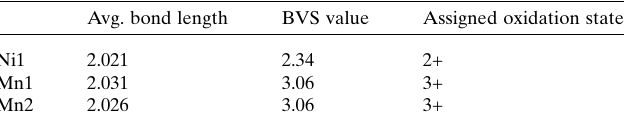
Table 1 Average bond length (A˚ ) and bond-valence-sum (BVS) values (v.u.) used to support assigned oxidation states of the nickel and manganese ions of 1 .